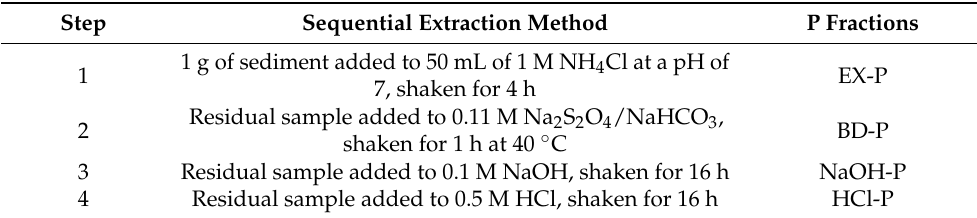
Table 1. Extraction procedure used in the present work